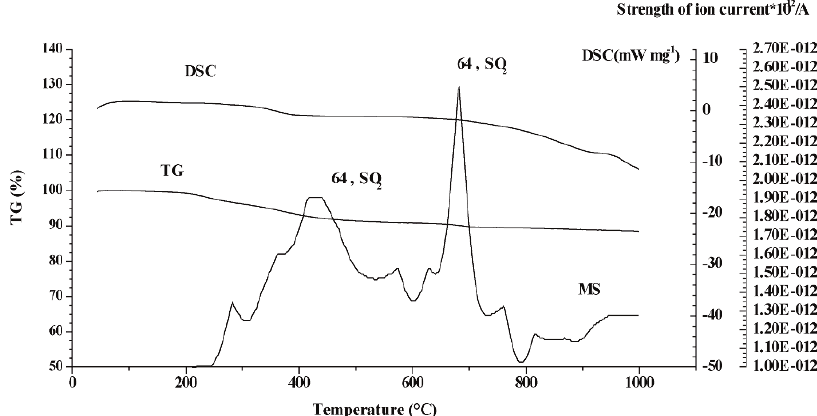
Figure 3. TG/MS analysis of EG (Under the condition of N